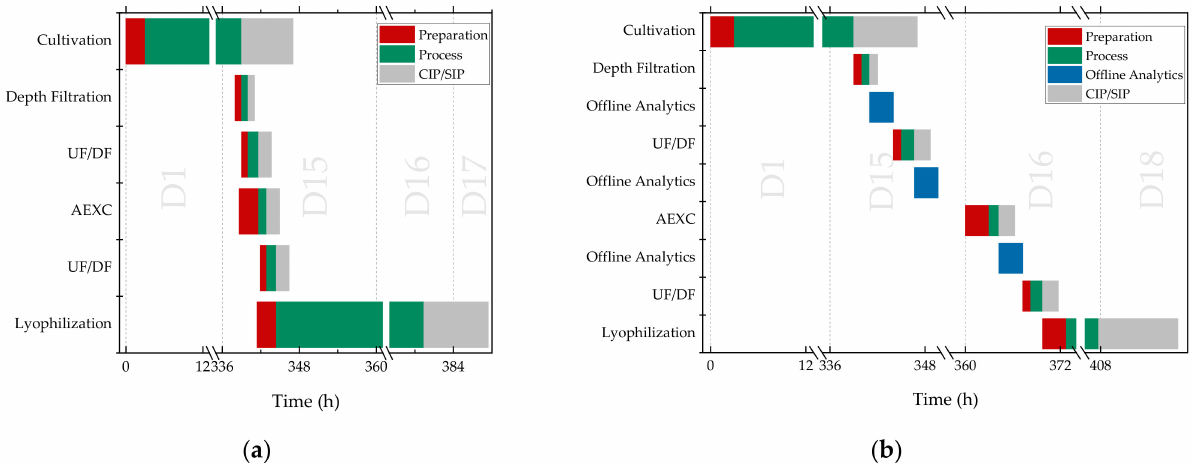
Figure 13. Optimized process schedule enabled by PAT for APC and DT ( a ) vs. conventional process schedule based on offline analytics ( b